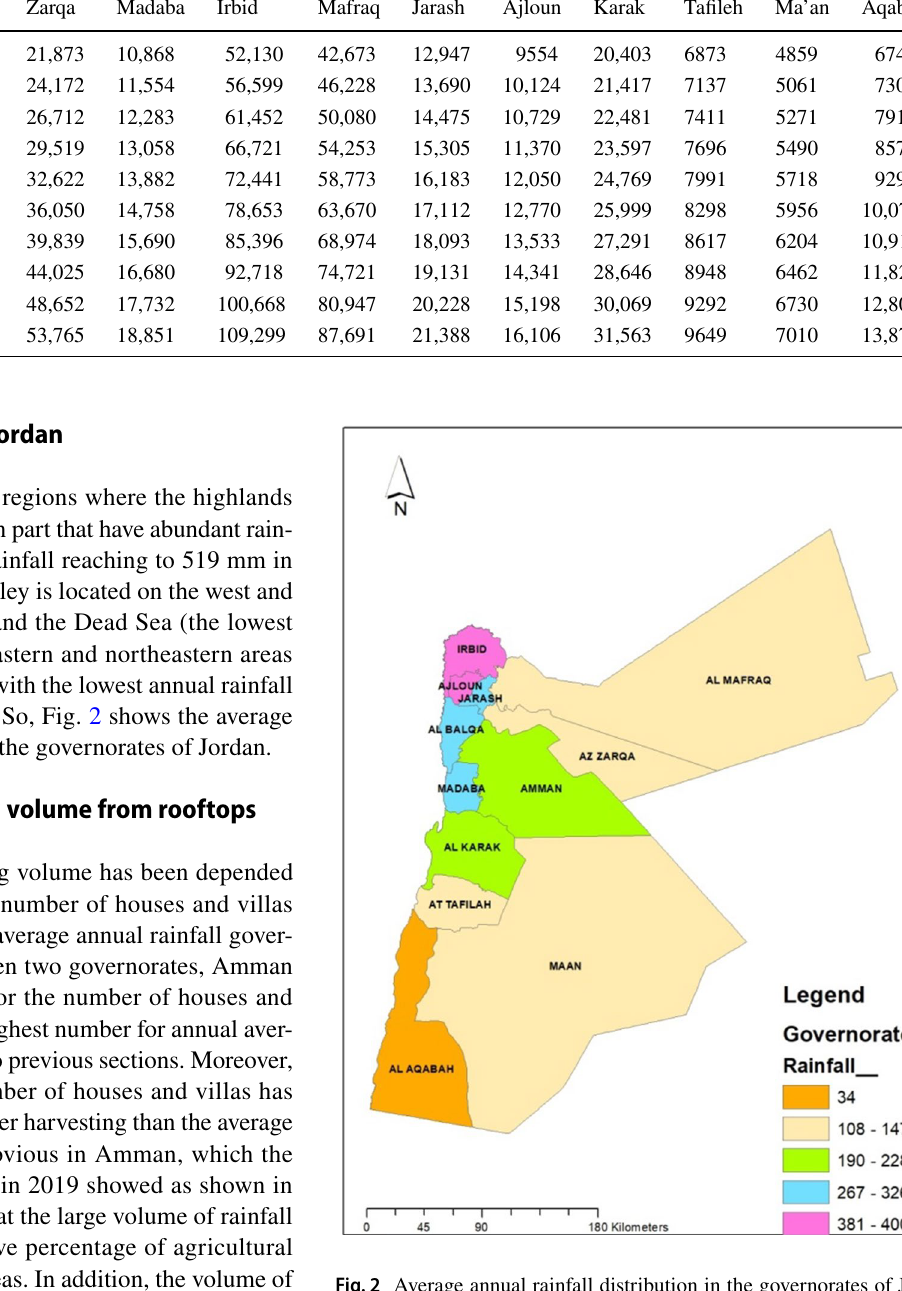
Fig. 2 Average annual rainfall distribution in the governorates of Jor-